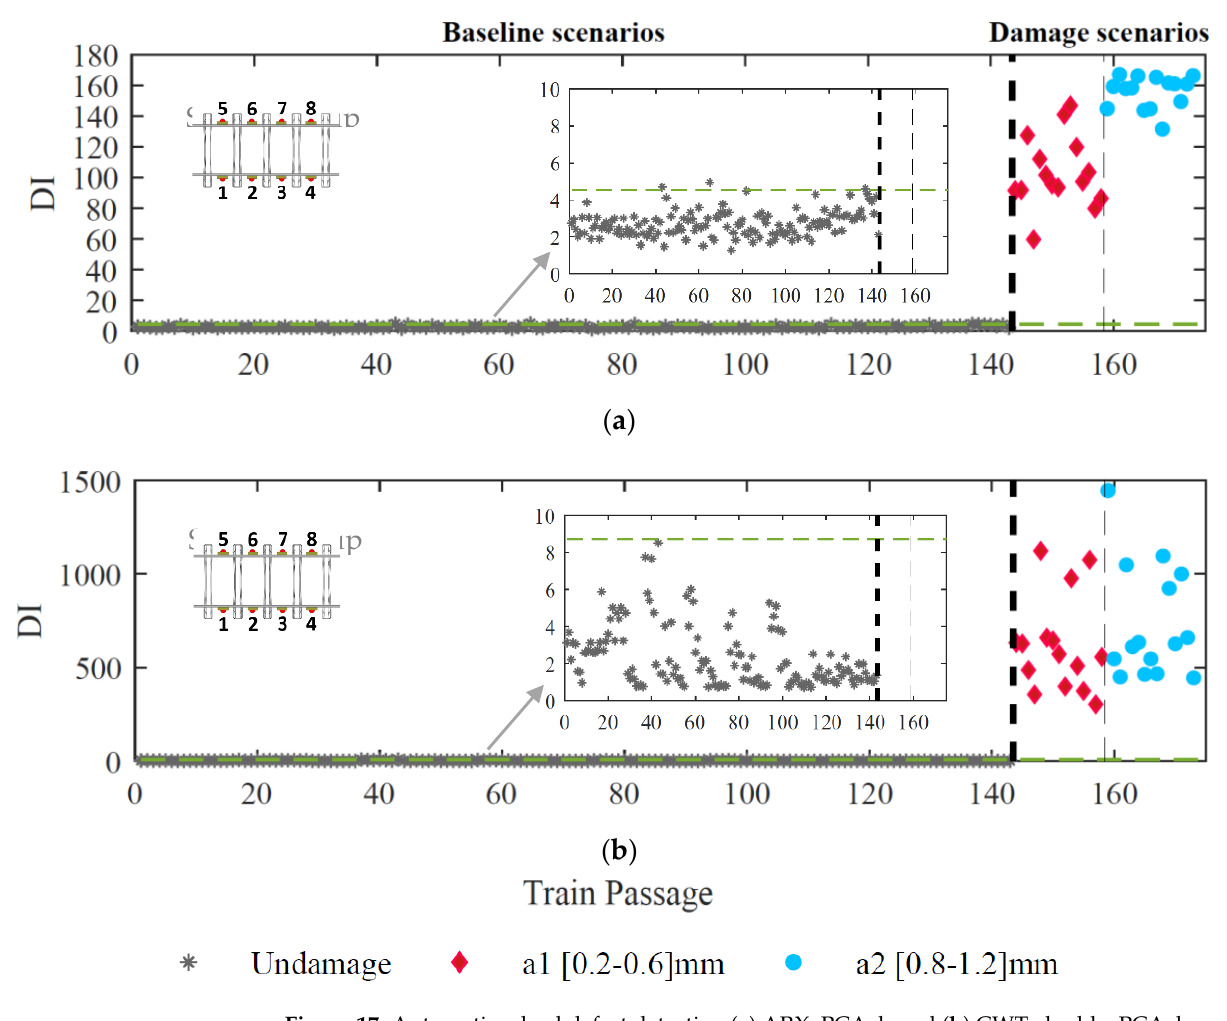
Figure 17. Automatic wheel defect detection ( a ) ARX – PCA – based ( b ) CWT – double – PCA – based.